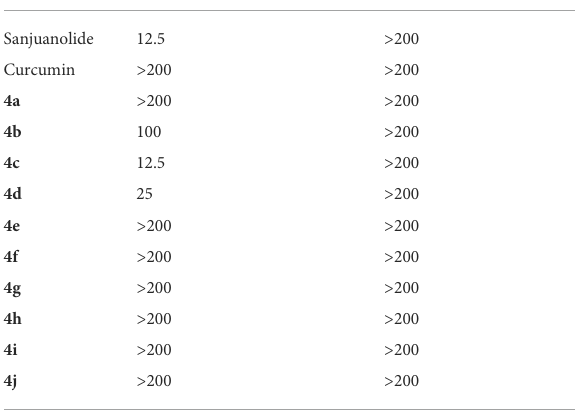
TABLE 1 Minimal inhibitory concentration (MIC) of curcumin, sanjuanolide, and its new derivatives (4a – 4j). Compound